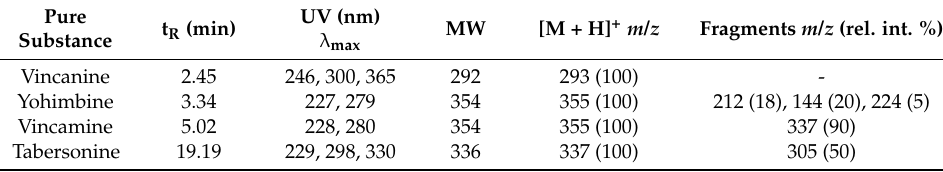
Table 1. UPLC-PDA-MS data for reference compounds in positive ion